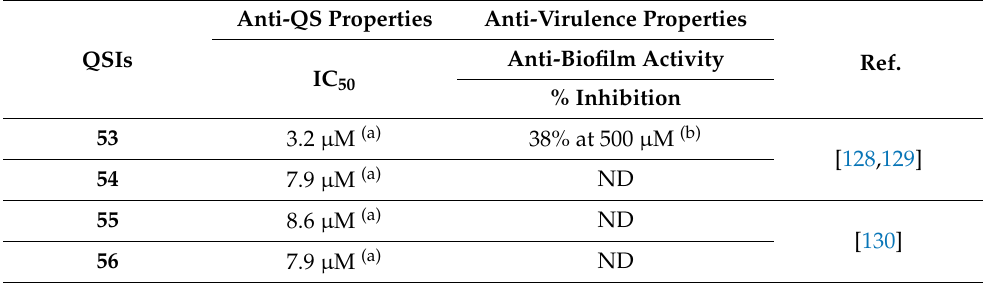
Table 7. Anti-QS and anti-virulence properties of PqsD inhibitors. Anti-QS QSIs